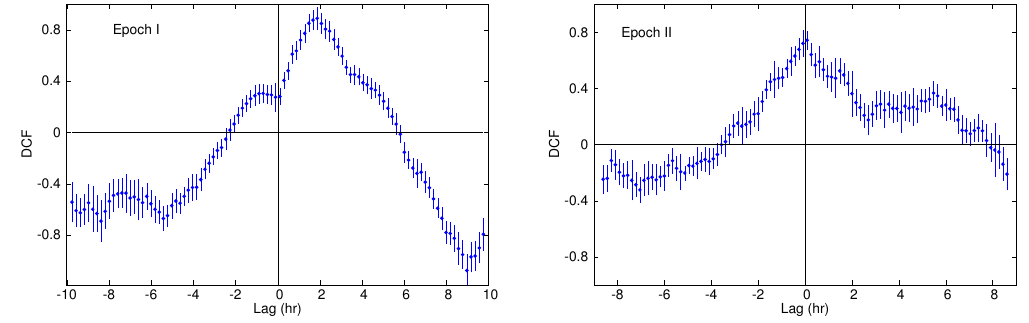
Figure 5. ( Left ): Discrete correlation function (DCF) between flux and polarization degree for Epoch I; ( Right ): Discrete correlation function between flux and polarization degree for Epoch II [18].